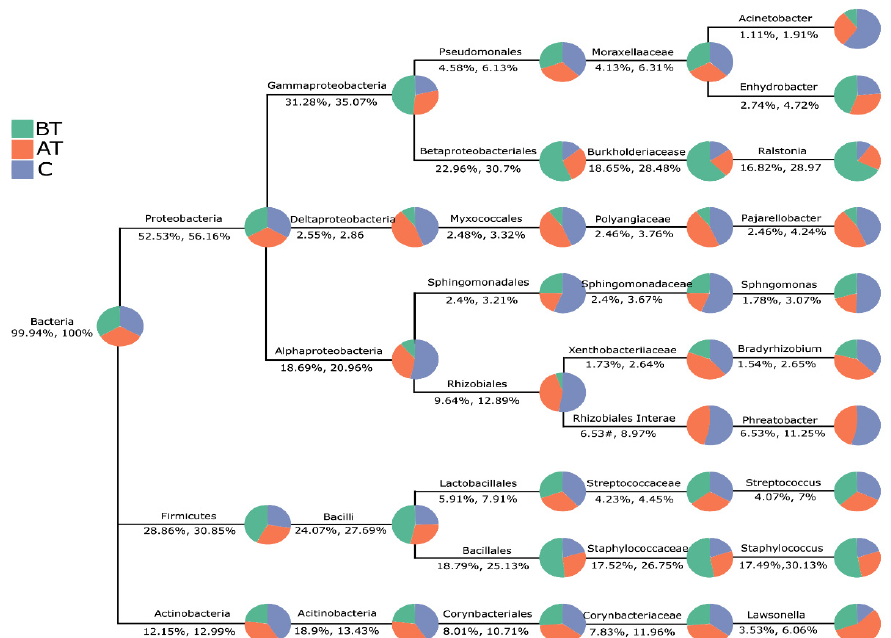
Figure 5. Specific taxonomic tree of facial microbiota (from phylum to genus) of the three experimental groups. Sectors with different colors in the pie chart represent different samples, and the size of the sector represents the relative abundance of the sample. The number below the classification name on the left side of the pie chart represents the average relative abundance (%) of all samples in this classification; the above number represents the total abundance.